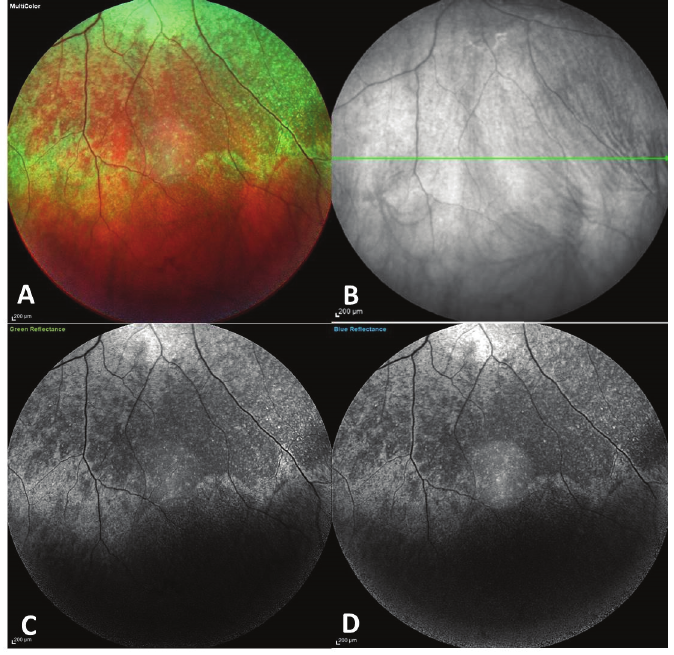
Figure 3. Peripheral fundus multicolor image (A) showed the lesions clearly. The red reflectance did not reveal the lesions (B). Green and blue reflectance showed the same pattern as the multicolor images (C & D).